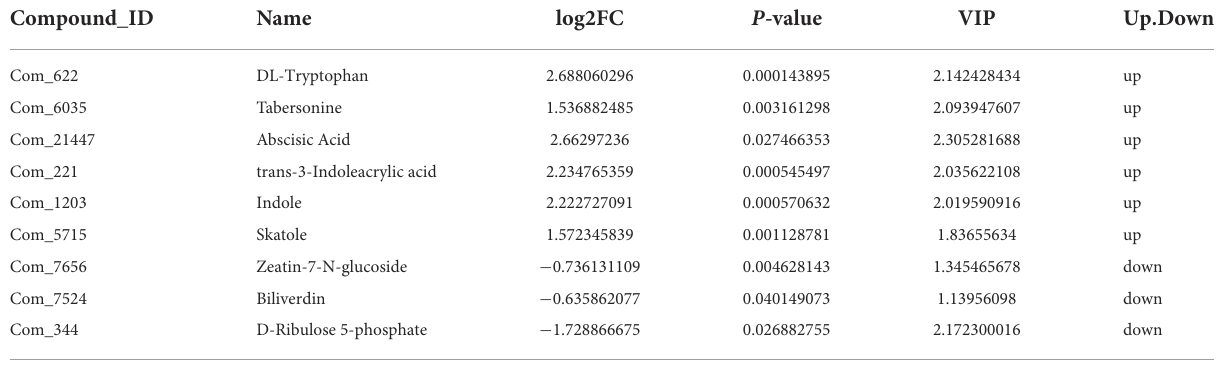
TABLE 2 Differential metabolites associated with growth hormone.